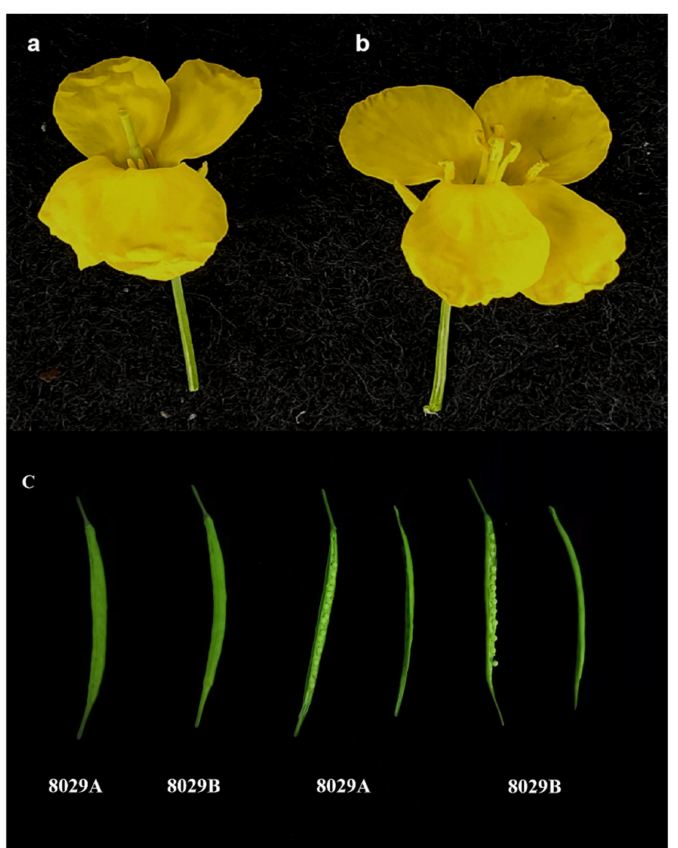
Figure 1. Flower morphology of 8029AB. ( a ) Male-sterile bud of 8029A. ( b ) Male-fertile bud of 8029B. ( c ) Siliques and seed setting of 8029A and